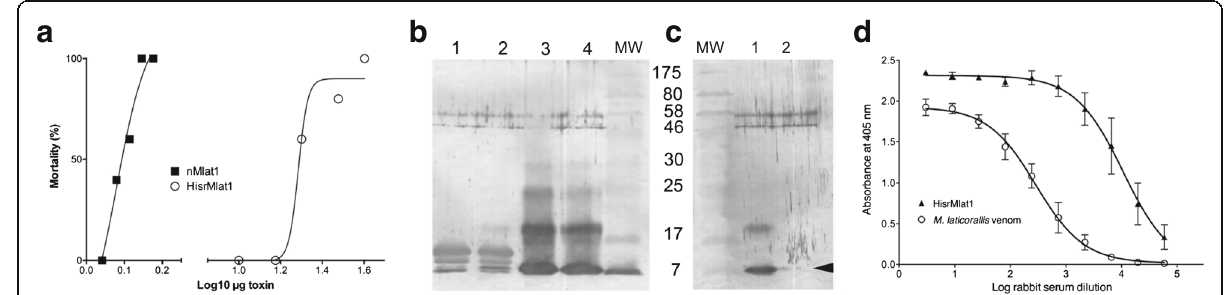
Fig. 5 Biological activity of native Mlat1 and HisrMlat1. a Dose-response of mice to intravenous injection of native Mlat1 and HisrMlat1. b Western-blot of Micrurus laticorallis venom (lanes 1 and 2) and HisrMlat1 (lanes 3 and 4) that were recognized using serum of rabbits immunized with recombinant HisrMlat1. Lane MW corresponds to the molecular weight markers (kDa). c Western-blot of HisrMlat1 (lane 1) and nMlat1 (lane 2) that were recognized using serum of horses immunized with sub-Saharan African elapid venoms. Lane MW corresponds to the molecular weight markers (kDa). d ELISA detection of M. laticollaris venom and HisrMlat1 using sera of rabbits immunized with